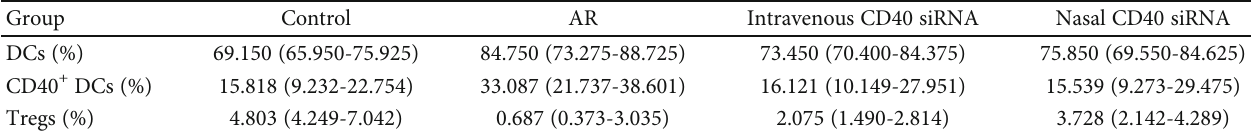
Table 1: The percentage of DCs, CD40 + DCs, and Tregs in the